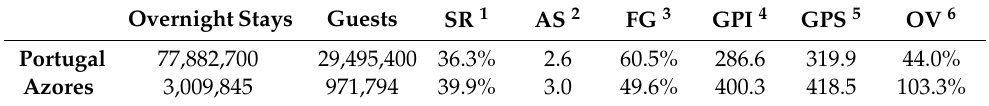
Table 1. Tourism activity in the Azores and Portugal in 2019 (INE 2022; SREA 2022). Overnight Stays Guests SR 1 AS 2 FG 3 GPI 4 GPS 5 OV 6 Portugal 77,882,700 29,495,400 36.3% 2.6 60.5% 286.6 319.9 44.0% Azores 3,009,845 971,794 39.9% 3.0 49.6% 400.3 418.5